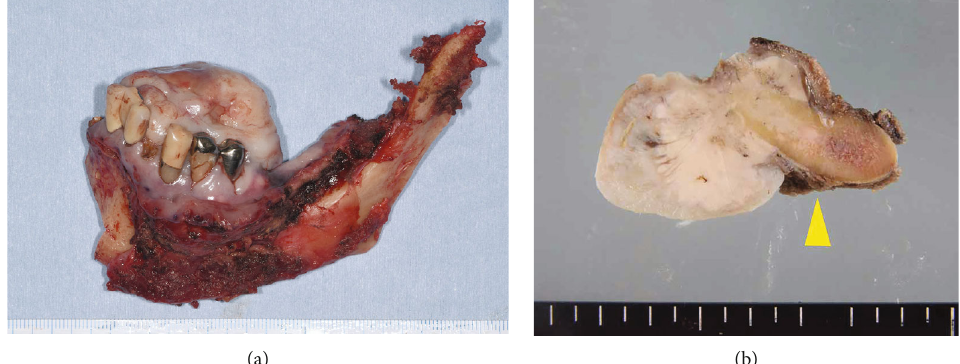
Figure 5: (a) Resected mandibular specimen revealing dominant exophilic proliferation. (b) Cut surface of the tumor after fi xing with formalin showing in fi ltration to the alveolar bone (arrowhead).